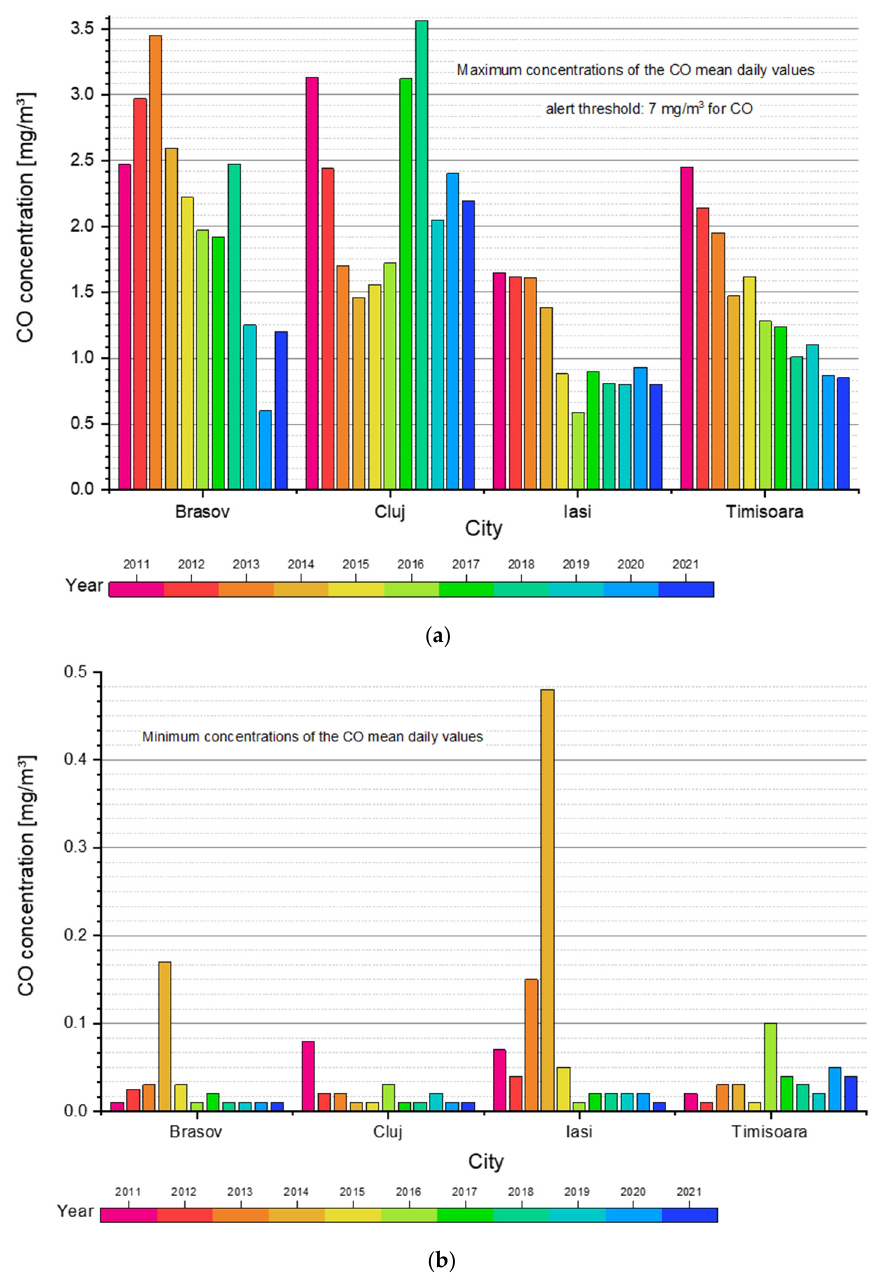
Figure 6. ( a ) Maximum concentrations of CO mean daily values depending on the alert threshold; ( b ) minimum concentrations of CO mean daily values depending on the alert threshold.